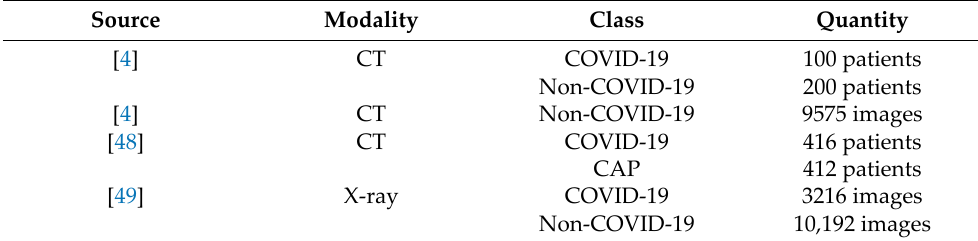
Table 1. Summary of datasets and